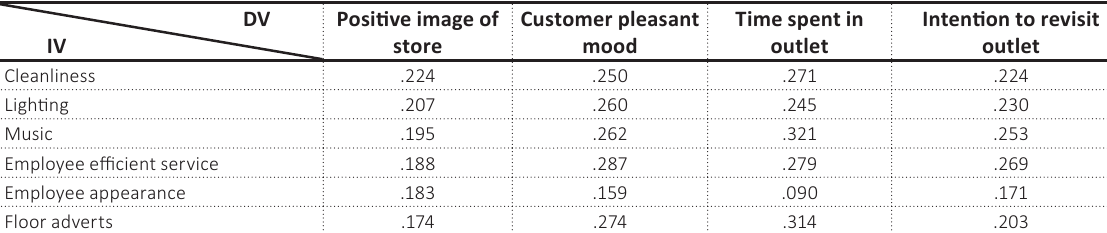
Table 7. Correlation